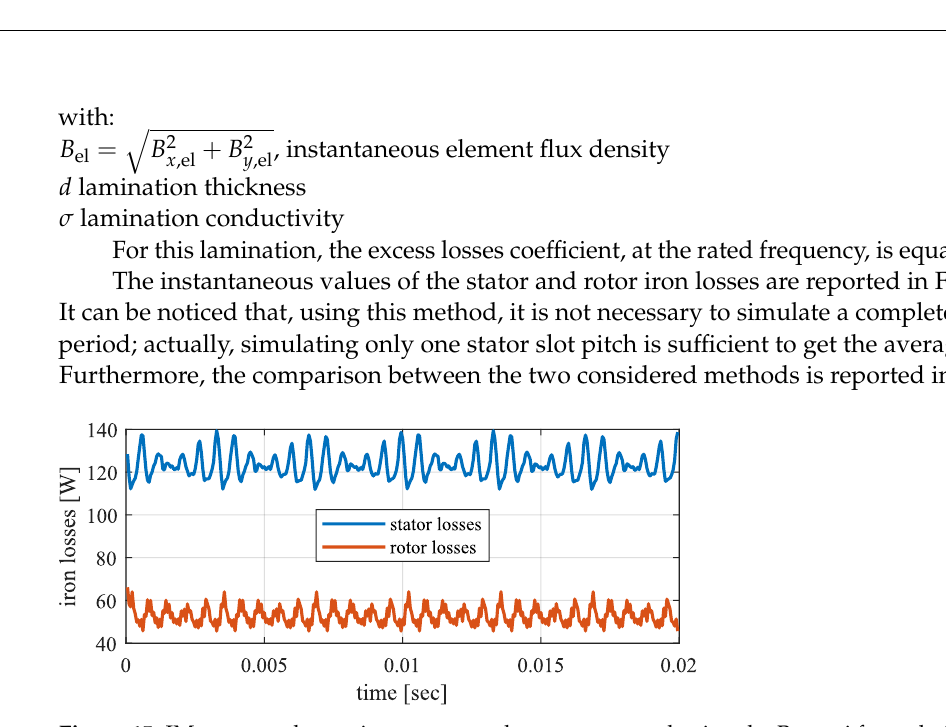
Figure 15. IM stator and rotor instantaneous losses, computed using the Bertotti formulation. Table 5. Comparison Steinmetz and Bertotti iron losses computation.